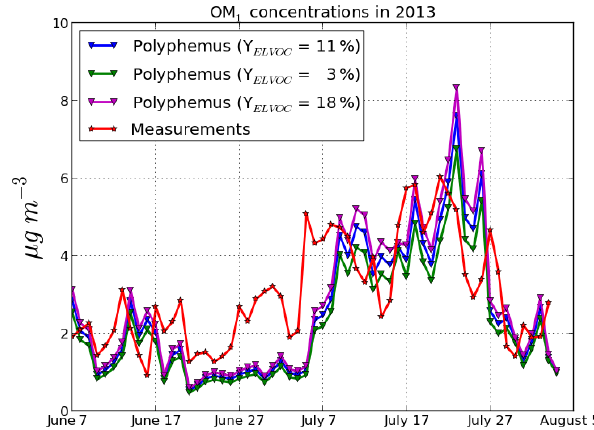
Figure D1. Simulated daily concentrations of OM 1 using a molar ELVOC yield of 11% (blue plot, reference simulation), 18% (magenta plot) and 3% (green plot).